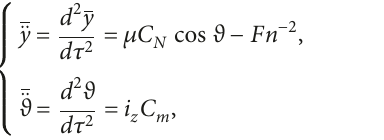
point vortices on the pro fi le. The fi rst free point vortex in the wake lies at the line tangential to the airfoil. The trailing edge is exactly in the middle between the fi rst free wake vortex and the last point vortex closest to the trailing edge on the pro fi le.